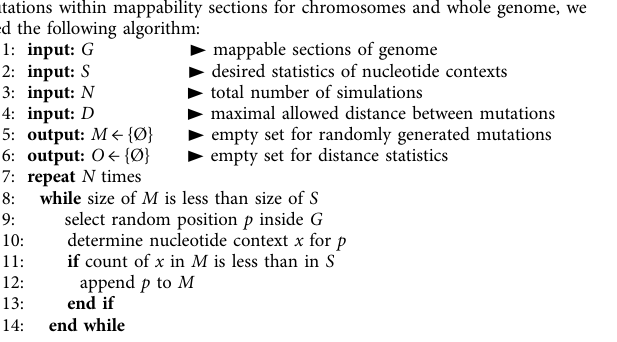
rendered 237 Mbp of 5 ′ proximal to TSS intergenic regions and 151Mbp of genic regions. Replication timing . We used repliseq data from 12 cell lines 57,58 to calculate consensus replication timing regions. For each 1-kb regions we calculated the standard deviation between all the cell lines and removed all regions with standard deviation higher than 15. For the rest of consistent regions across different cell lines, we calculated the mean values and used them during analysis. The genome was divided into fi ve bins (10 − 25, 25 − 40, 40 − 55, 55 − 70, 70 − 85) according to the replication timing values and mutational density was calculated for each bin adjusting for the length of each region. We computed dependence of mutational density on replication timing independently for genic and intergenic regions separating mutations on transcribed strand and untranscribed strands. Epigenetic marks and mutational density . To infer relationship between muta- tion density and intensity of various epigenetic marks (methylation, H3K27ac, H3K27me3, H3K36me3, H3K4me1, H3K9me3), we downloaded bigwig fi les of the Roadmap Epigenomics Project 54 and converted them to wig and then bed fi les (tissue E050). The mean intensity of each mark was calculated for 1-kb non- overlapping windows across autosomes with BEDOPS v2.4.37 (bedmap) soft- ware 59 . We used only genomic windows with high alignability (equal to 1) along at least 90% of a window. Mark intensities were normalized to 1 − 100 range. For each window we split mark intensities into 5 quantiles (cut2() function in R 60 ) and calculated the relative mutation density of each mark for intergenic regions, transcribed and untranscibed strands of genes. The ChromHMM Expanded 18-state models of chromatin states (E050) were downloaded as bed fi le 54 and all the windows with the highest alignability spanning less than 90% of the window were fi ltered out. Then we calculated relative mutation density for each sample and chromatin state for XP-C leukemia and sporadic myeloid neoplasms. Replicational strand bias . We used data from Okazaki-seq experiments data 61 for GM06990 and HeLa cell lines to infer the regions of genome preferentially repli- cating as lagging or leading strand relative to the reference human genome. 1kbp genomic regions for which values representing the direction of replication fork differed between cell lines >0.4 were removed. We calculated the ratio of the densities between mutations from pyrimidines (C, T) and purines (G, A) for each bin ( − 1 to 0.5, − 0.5 to 0, 0 to 0.5, 0.5 to 1) of the preferential replication direction (negative values correspond to genomic regions where reference strand is replicated as lagging strand; and positive values — as leading) similar to the methodology of Seplyarskiy et al. 62 . Clustered mutations . To evaluate the distribution of mutations across the genome for the presence of clustered mutations in our dataset, we performed Monte Carlo simulations for the intermutation distances distribution of random mutations for ranges between 2 and 10,000 bp for each studied sample. We developed a math- ematical model of the Monte Carlo method for random mutations generation based on the following statements: (1) positions of mutations are random and uniformly distributed along the genome; (2) random positions are selected from the same set of genomic intervals as original somatic mutations; (3) the number and nucleotide context spectrum of randomly generated mutations exactly matches somatic mutations in the corresponding sample. As follows, our simulations are based on the discrete homogeneous Poisson point process. The Monte Carlo simulations were performed using Java programming language, discrete random positions were generated with standard Java Random class (Supplementary code). Data analysis was carried out with MathWorks MATLAB. We randomly assigned mutations giving their trinucleotide (3 bp) contexts and repeated the procedure 30,000 times for each sample (Supplementary Fig. 5). To compute statistics for the distances between neighbors for randomly placed mutations within mappability sections for chromosomes and whole genome,